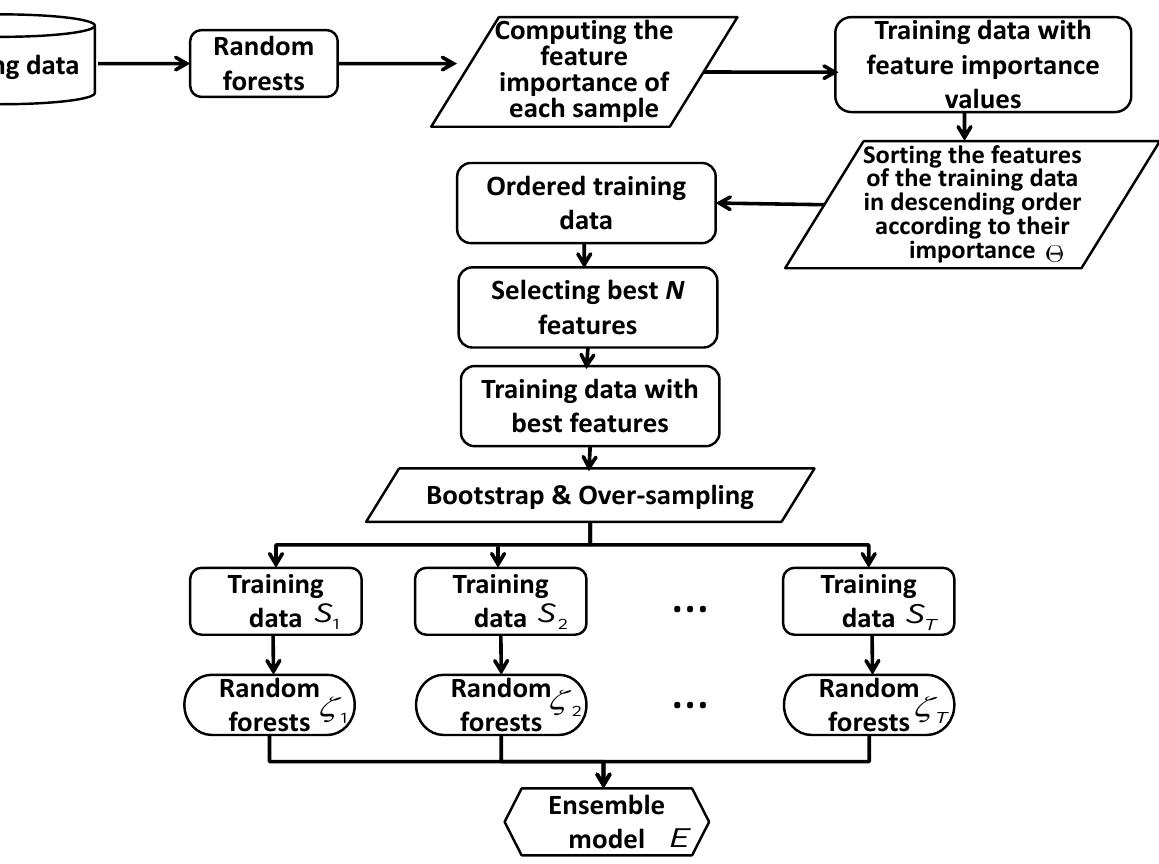
Figure 2. Flowchart of the double ensemble-based multi-class imbalanced data learning